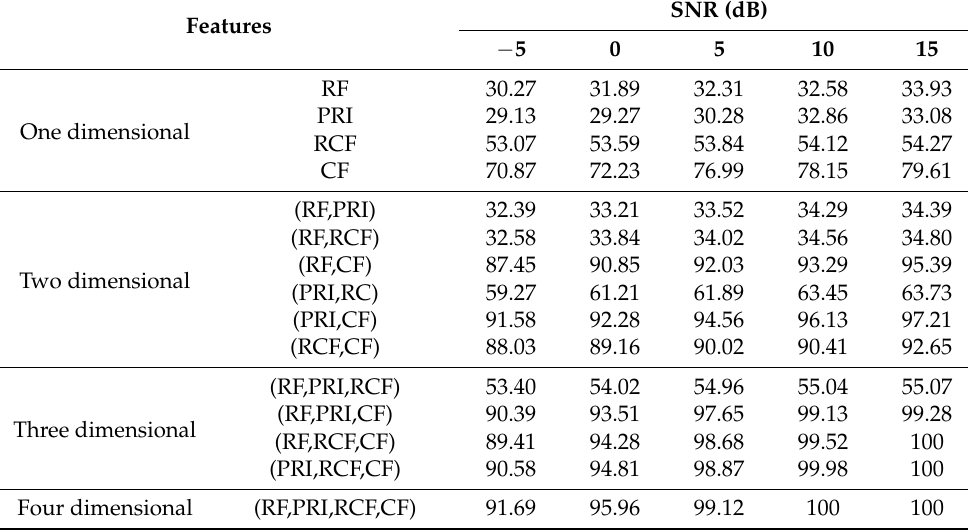
Table 7. Recognition results by CNN in different SNRs (%).